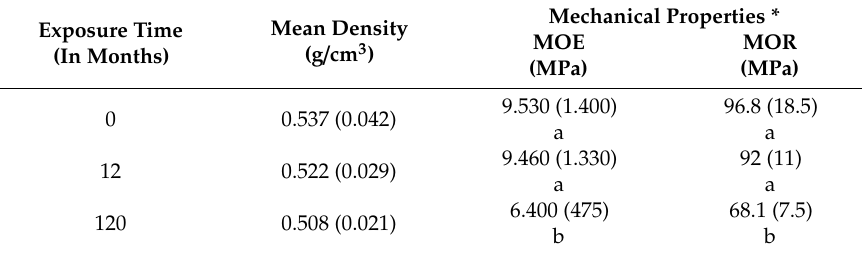
* Mean values of 10 replicates (standard deviations in the parentheses). Values followed by the same letter for a given property do not differ from one another by Duncan’s multiple range test ( α = 0.05).